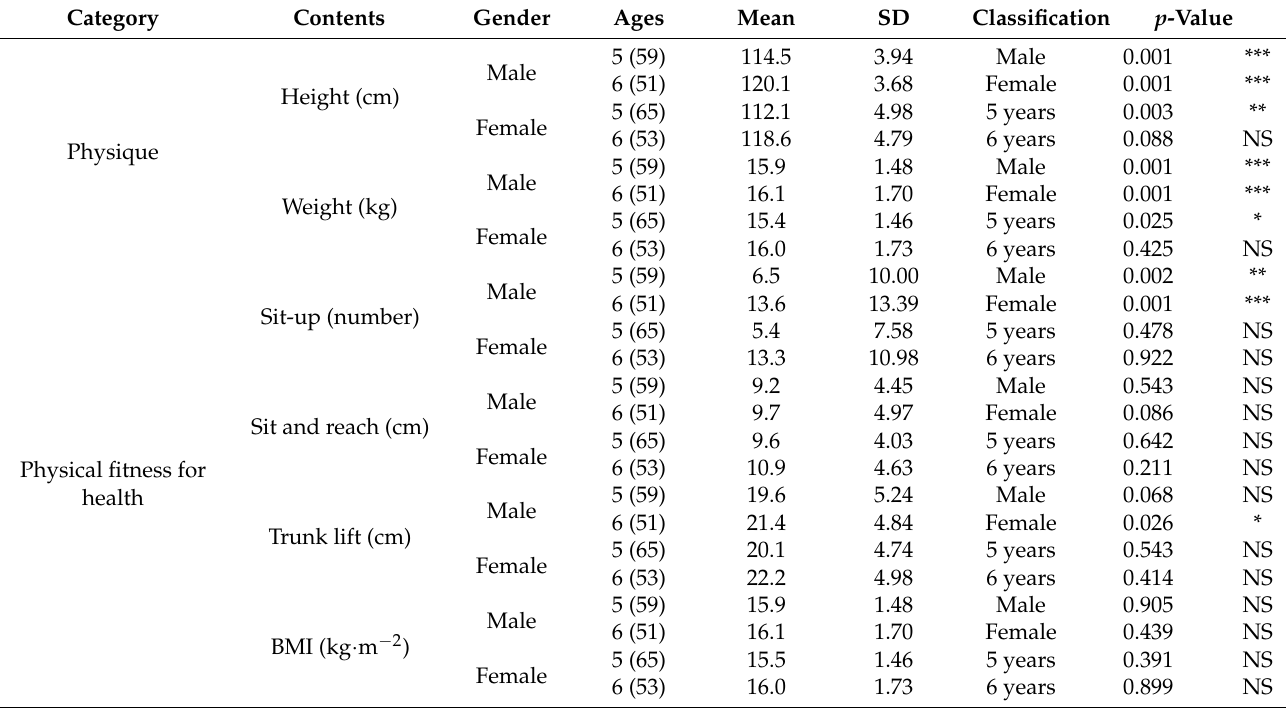
Table 7. Children’s physical activity